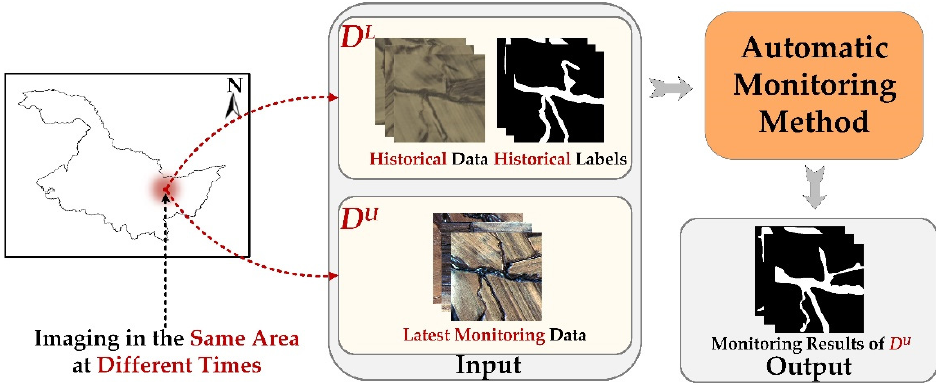
Figure 1. The automatic monitoring process of gully erosion. The input contains historical data with labels ( D L ) and the latest monitoring data without labels ( D U ). The output is the monitoring results of D U .